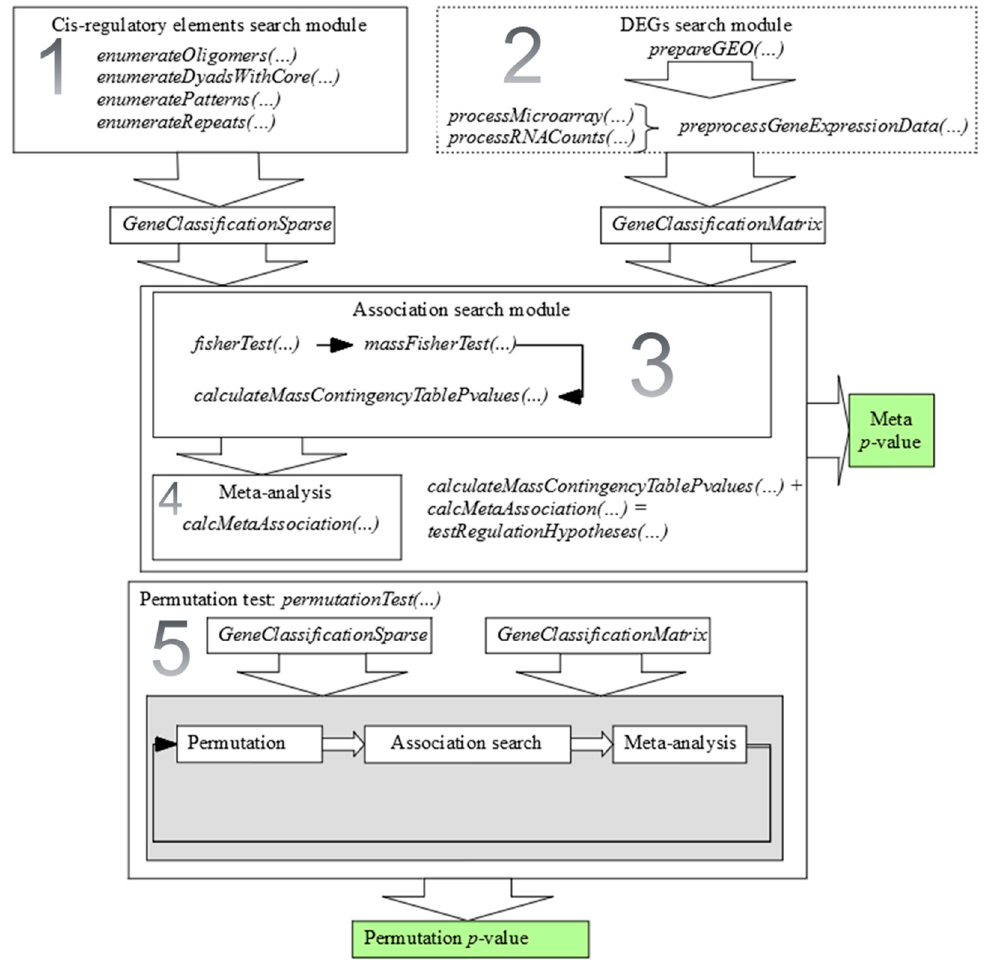
Figure 1. Scheme of metaRE modules that implement a five-step pipeline of the search for cis- elements significantly associated with differential gene expression over multiple datasets. DEGs—differentially expressed genes. Different modules are highlighted with squares; final sets of p- values are painted green. Described in the Methods steps are enumerated on the figure.